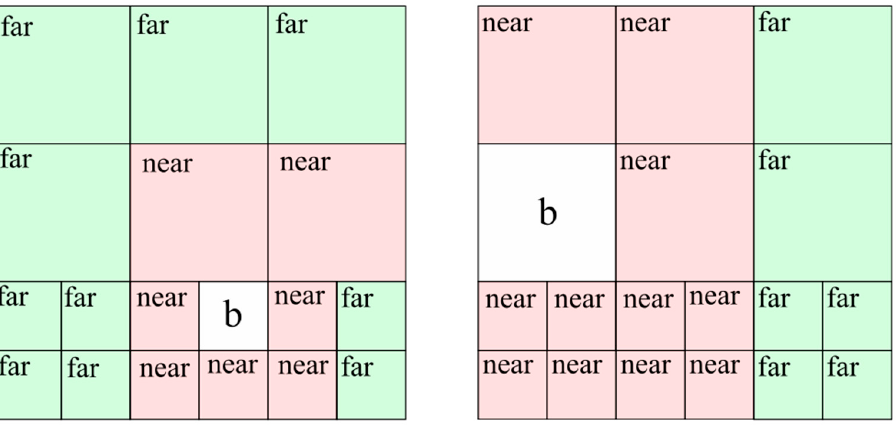
Figure 5. The box b is the source box. The near zone is depicted as pink, and the far zone is depicted as green.